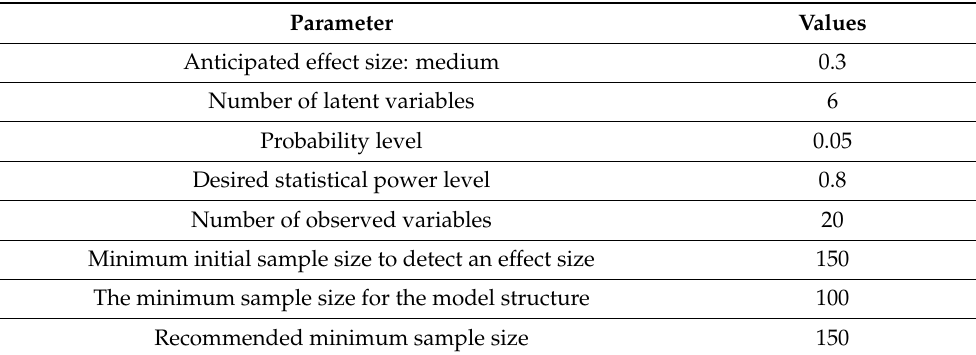
Table 1. Sampling parameters and